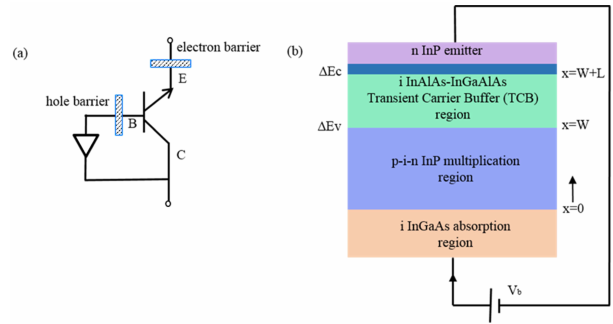
Figure 11: MAGIC detector equivalent circuit (a). An example design of the MAGIC detector with InGaAs/InP material (b). ∆E c and ∆E v are the conduction band and valence band offsets at the material interfaces. V b is the applied voltage